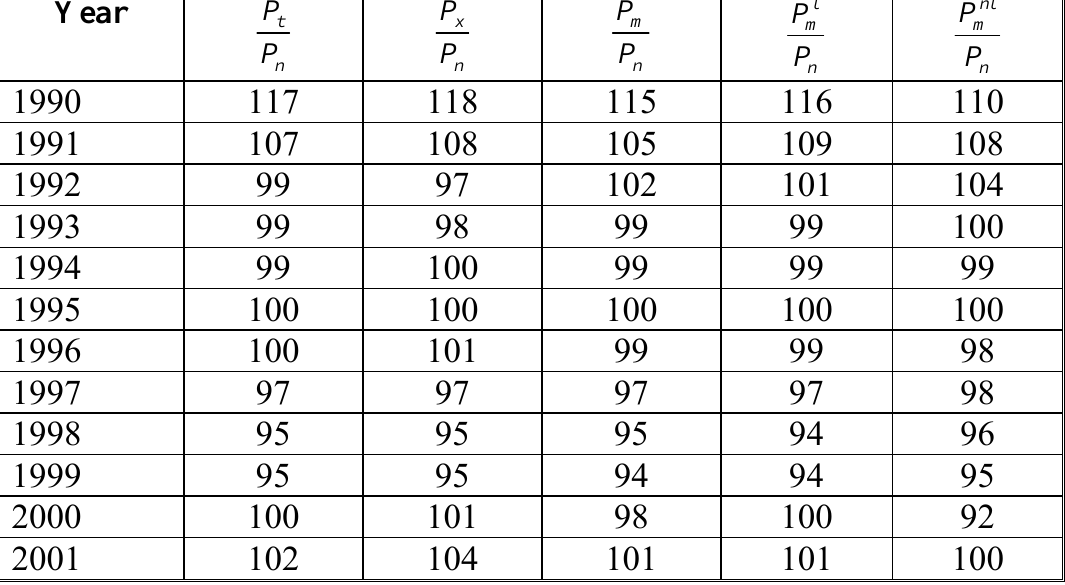
Source: Table 3, authors'